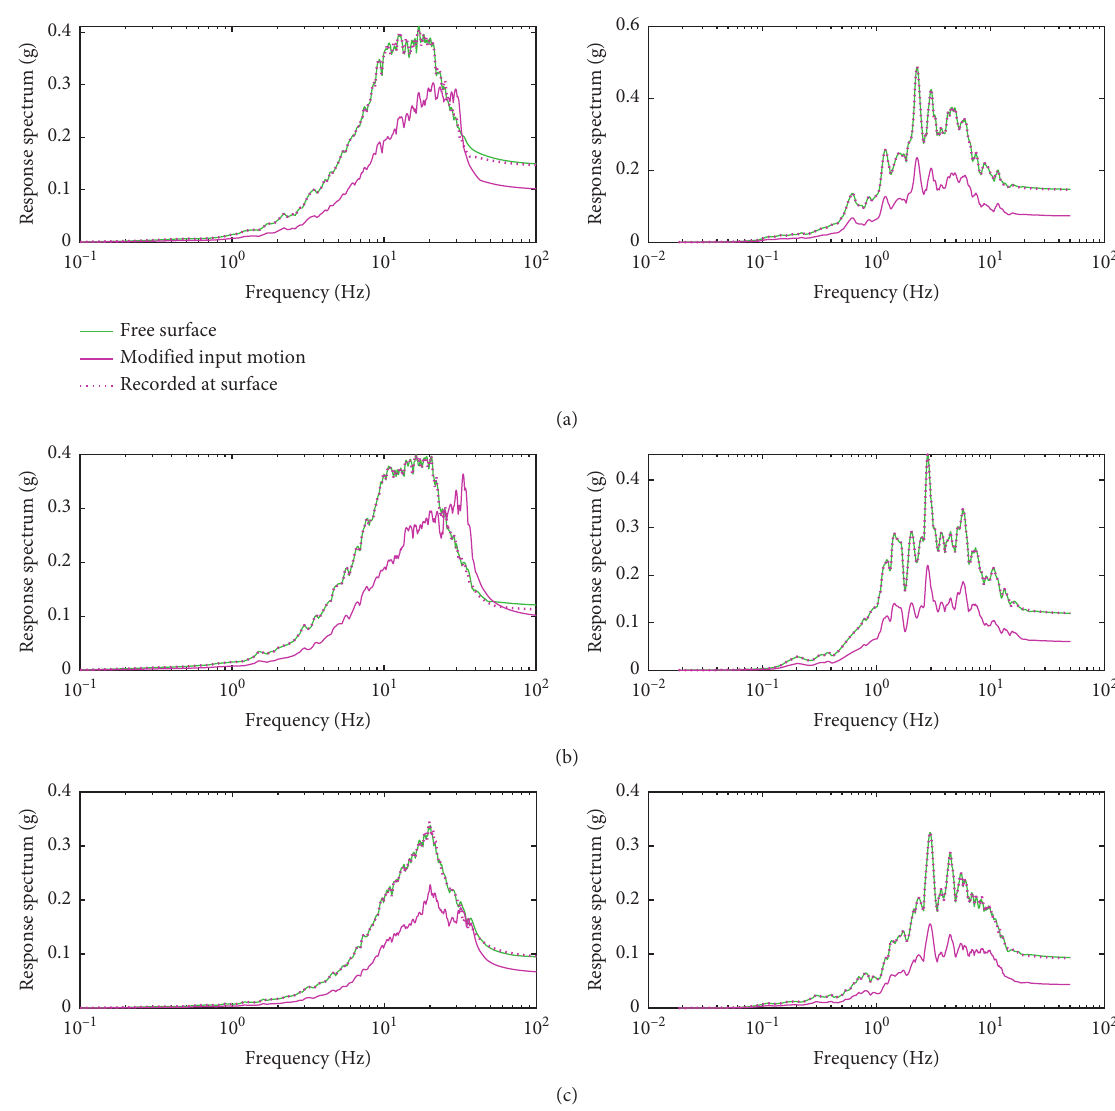
Figure 7: Acceleration response spectrum of Swedish design earthquake (left) and Taft earthquake (right) at free surface (control point), at base (deconvolved), and recorded at column surface (convolution), in the (a) stream, (b) cross-stream, and (c) vertical directions.